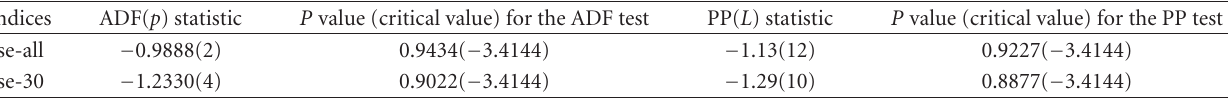
Table 3: Stationarity test results.